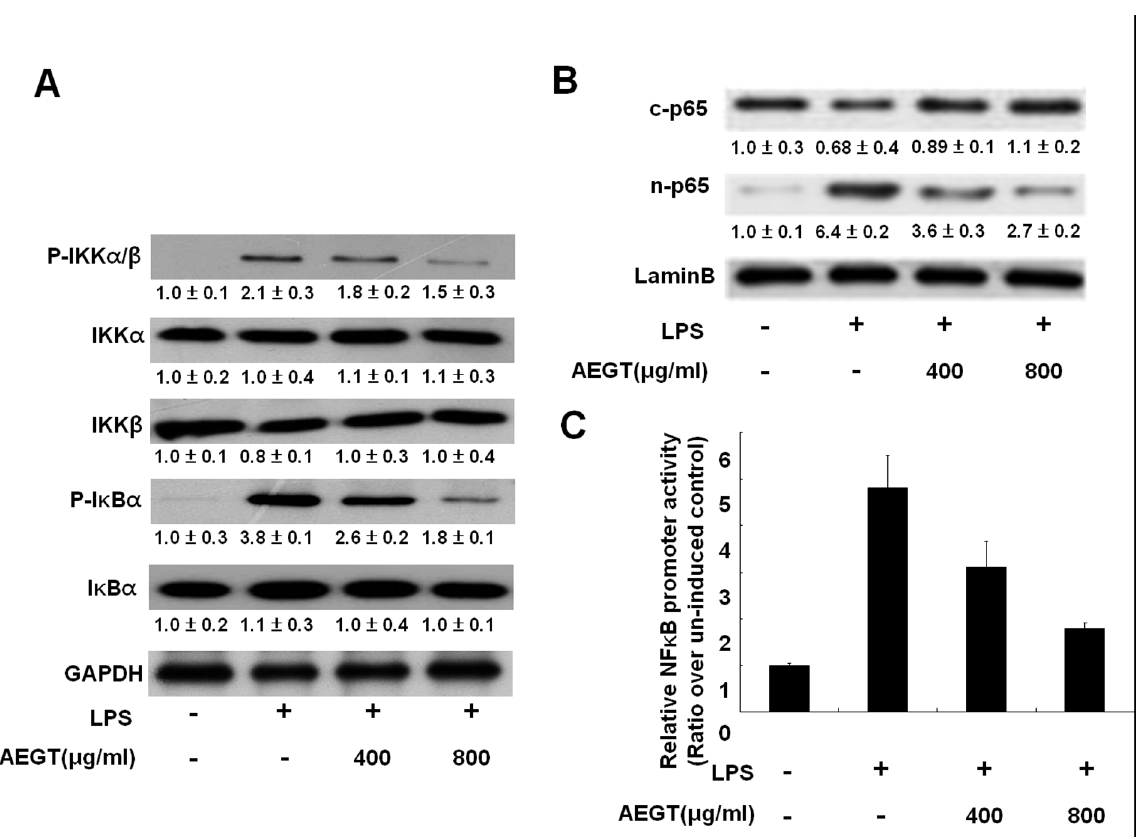
Figure 4. Effect of AEGT on NF- k B activation in LPS-stimulated RAW 264.7 cells. (A) The RAW264.7 cells were seeded in a 24-well plate, and treated with 400 or 800 m g/ml AEGT for 1 h and then incubated with 1 m g/ml LPS for 2 h. The levels of total protein and phosphorylated IKK a , IKK b , and I k B a were analyzed by western blot analysis with specific antibodies. The relative value of the LPS- group or AEGT/LPS-treated group over the untreated group was measured by densitometry following normalization to cellular GAPDH levels. In the NF- k B activation assay, the cells were transfected with a pNF k B-Luc reporter plasmid. Subsequently, the transfected cells were treated with 400 or 800 m g/ml AEGT for 1 h, and then incubated with 1 m g/ml LPS for 2 h. The cell lysates and nuclear fraction were collected for western blot (B) and luciferase activity (C) analyses, respectively. The basal level of promoter activity in the AEGT/LPS-untreated cells was defined as 1. Error bars indicate the means 6 SD of three independent experiments. * P , 0.05; ** P ,